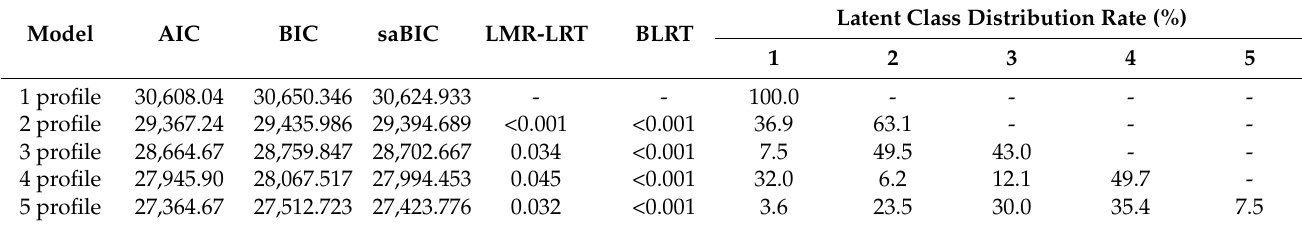
Table 3. Model fit of latent profile analysis of child-rearing attitude (8th wave).